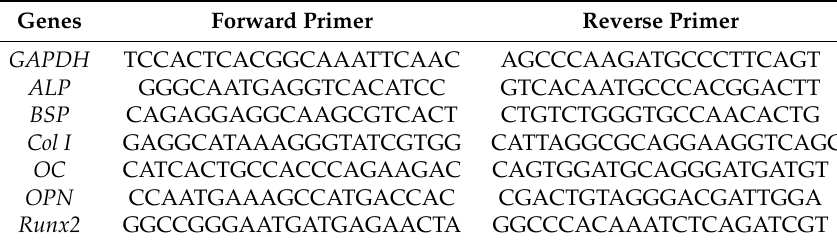
Table 1. Sequences of primers used for quantitative real-time